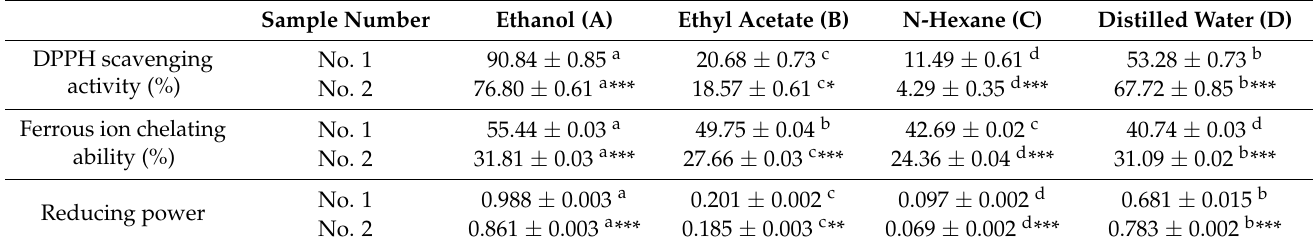
Table 2. Comparisons of the antioxidant capacities of the four solvent extracts of the two varieties of Hang